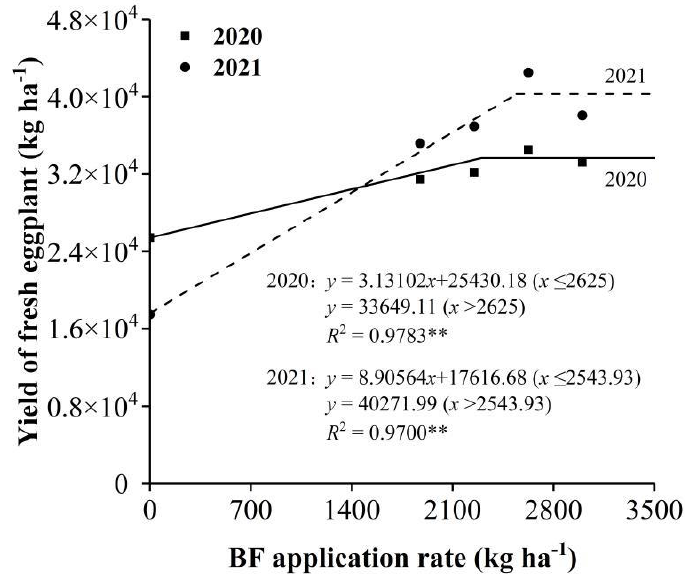
Figure 2. Effects of BF application rate on the yield of fresh eggplant. ** represents significant at α = 0.01 probability level. Table 2. Effects of BF on quality of fresh eggplant in 2020 and